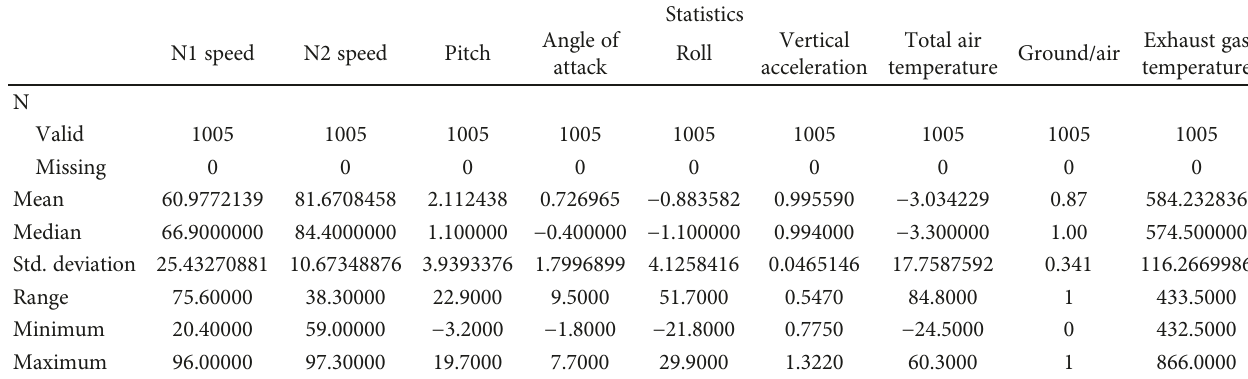
Table 2: Training data range used in the prediction of EGT.